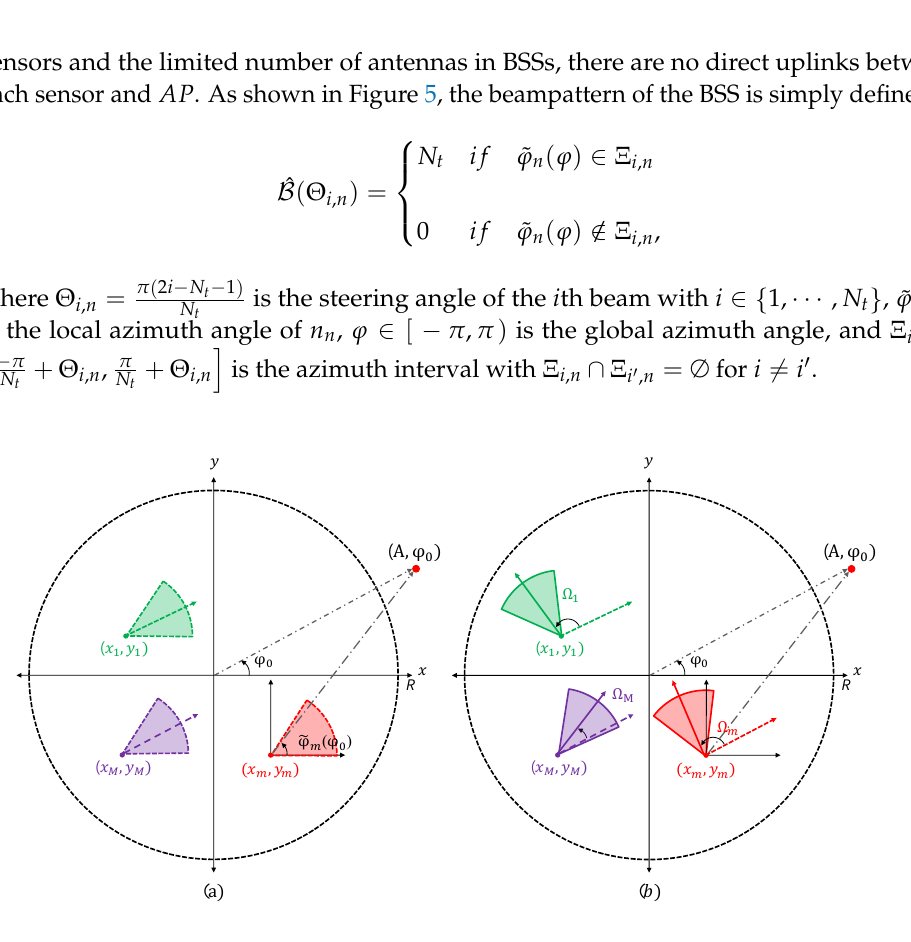
Figure 4. The system model ( a ) without or ( b ) with the effect of irregular mounting surface.